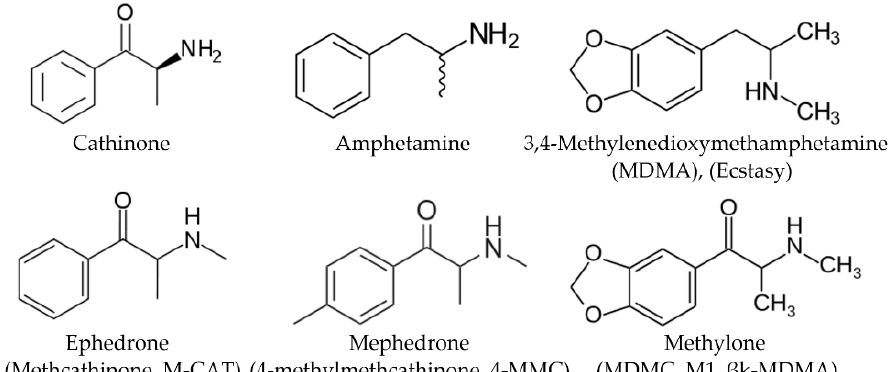
Figure 1. Chemical structures of selected cathinones and amphetamines.